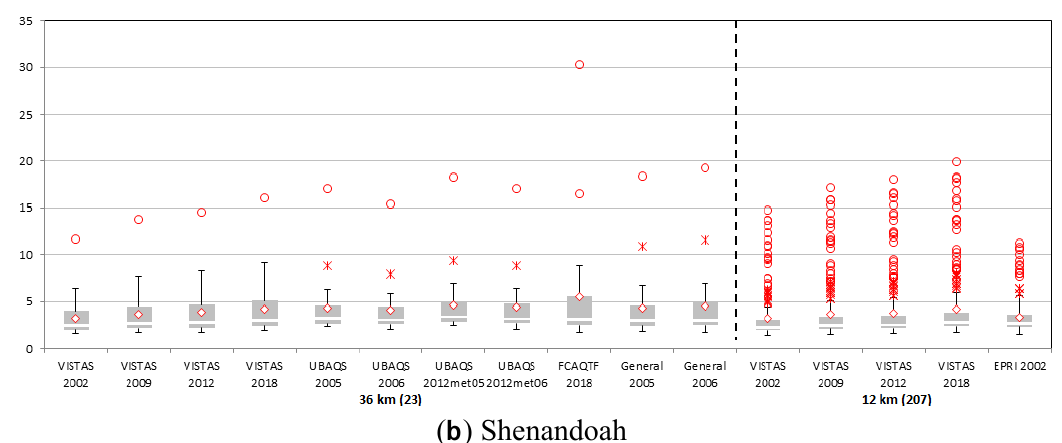
; ( b ) TNO and ( c ) LNH X Y X